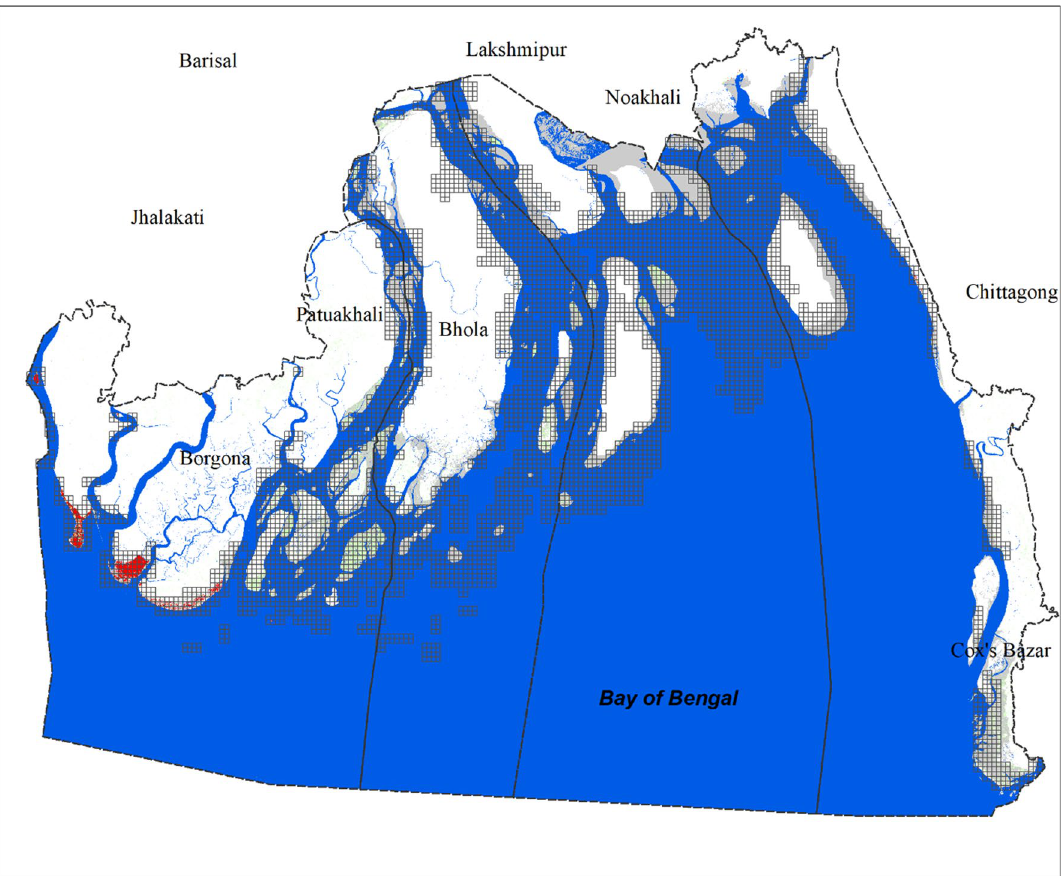
Fig. 4 Distribution of the 1 km 1 km grid across the study area. Planted mangroves and mudflats are important factors of the study, therefore, × in the area where these land covers are absent, the 1 km 1 km grid was not considered ×